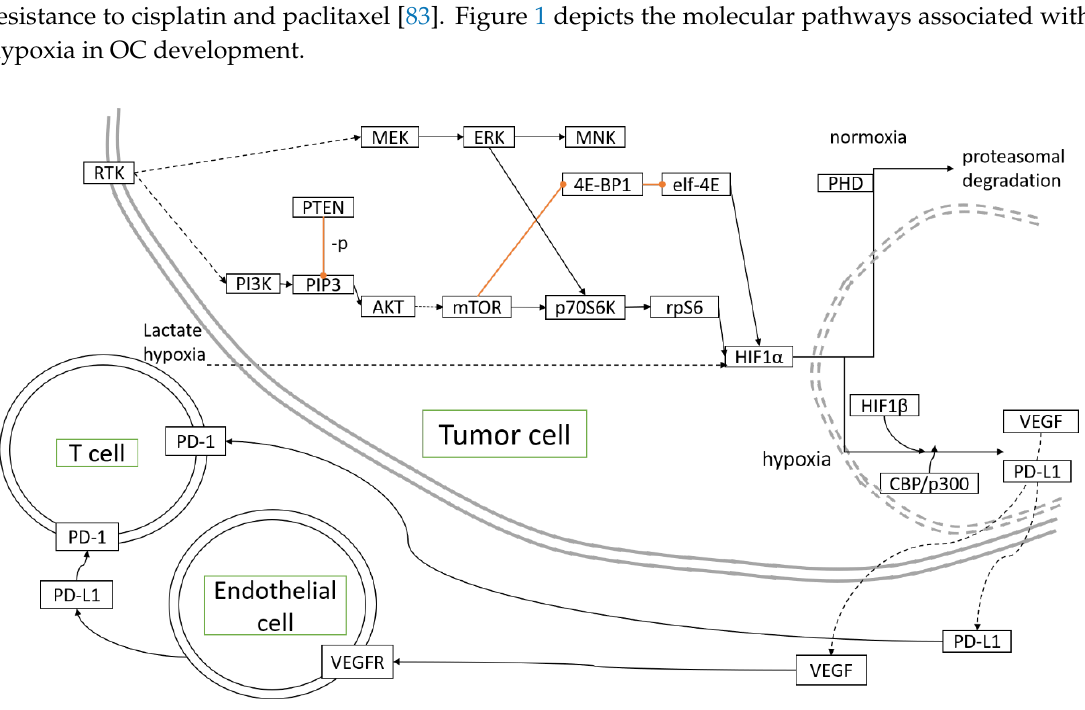
Figure 1. Molecular pathways activated and controlled by hypoxia in ovarian cancer development . inhibition, direct interaction / activation, indirect interaction / activation.